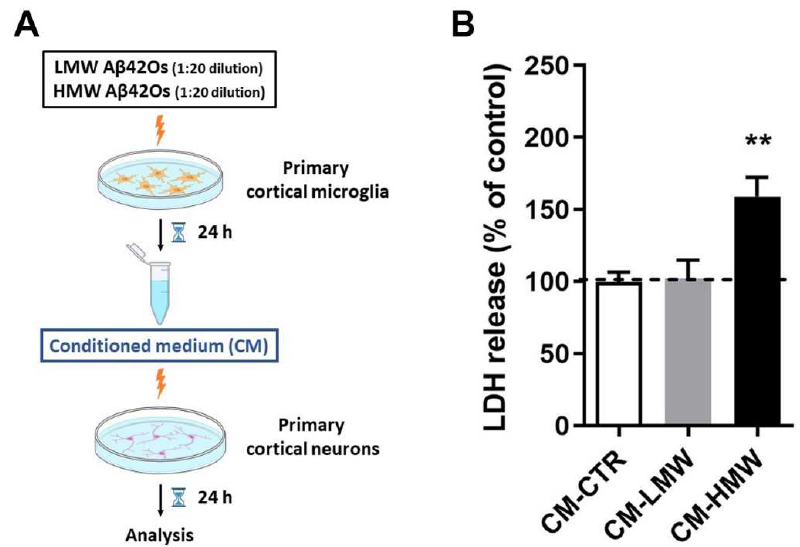
Figure 6. Effect of microglia-conditioned media on neuronal cell toxicity. ( A ) The procedure of collecting microglia-conditioned media to stimulate primary cortical neurons. ( B ) Primary cortical neurons were cultured from E17 rat embryos and after 7 days in vitro were exposed for 24 h to conditioned media from microglia untreated (CM-CTR) or treated with 1:20 dilution of LMW (CM-LMW) or HMW (CM-HMW) Aβ42Os for 24 h. At the end of incubation, cell toxicity was determined by LDH assay. Results are expressed as percentage of LDH release relative to control cells (dashed line). Data are means ± SEM of 3 independent experiments, each performed in duplicate. ** p < 0.01 versus control cells. One-way ANOVA, followed by Holm–Sidak’s multiple comparison test.